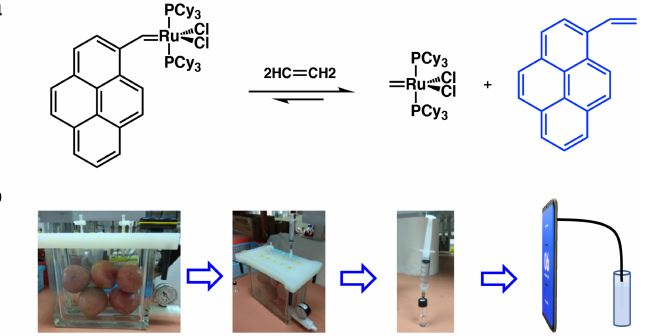
Figure 2. ( a ) Ethylene detection mechanism of the PYG probe; ( b ) schematic steps for ethylene detection using SOFS coupled with